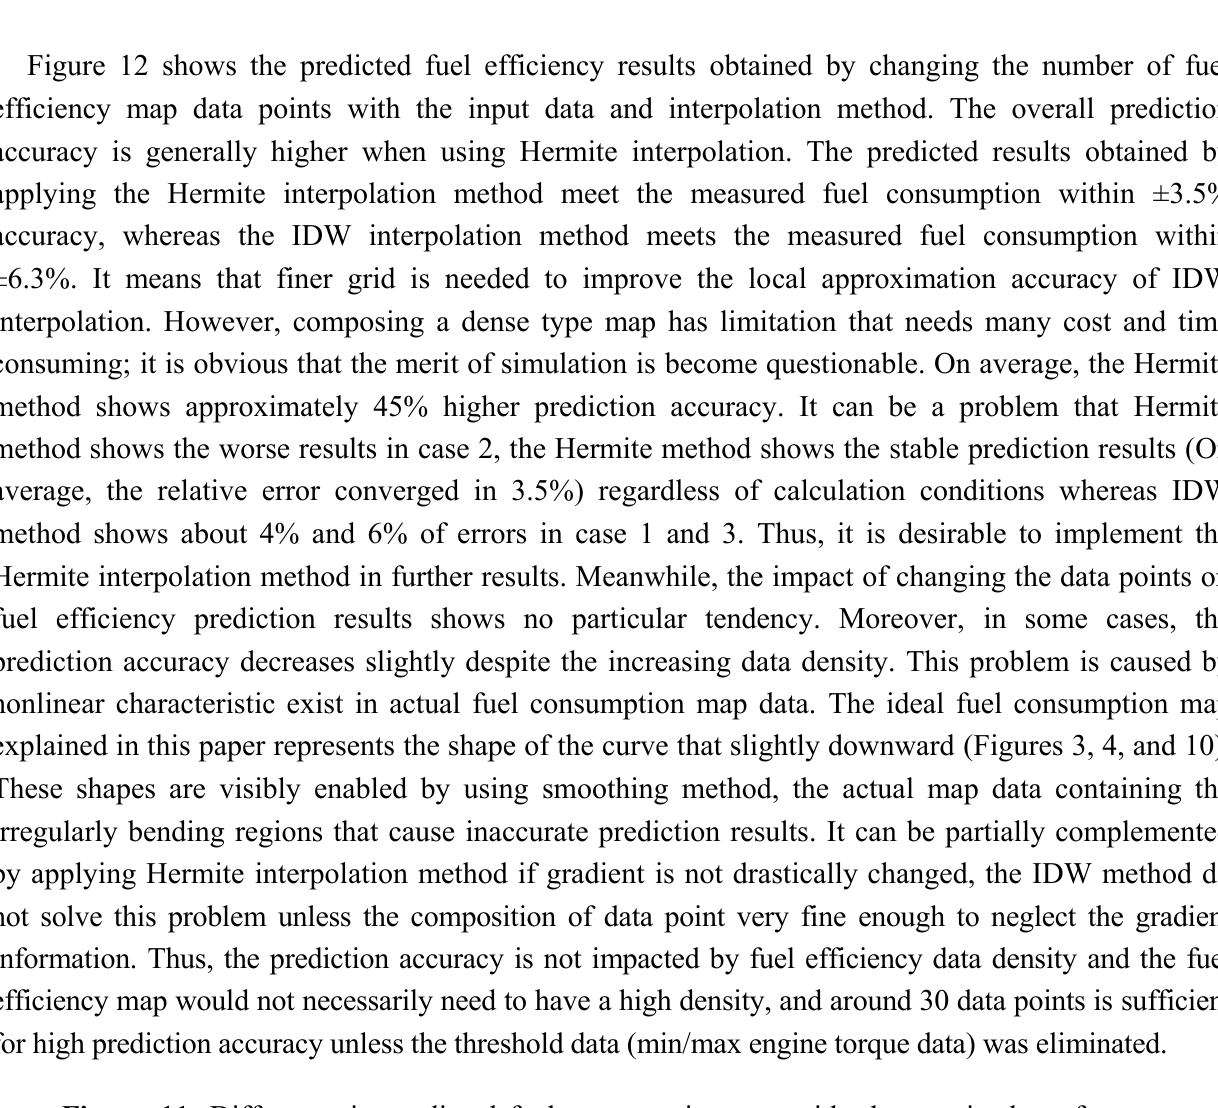
Figure 11. Difference in predicted fuel consumption rate with changes in the reference data point (IDW interpolation method): ( a ) appropriate fuel efficiency map composition ( b ) inappropriate fuel efficiency map